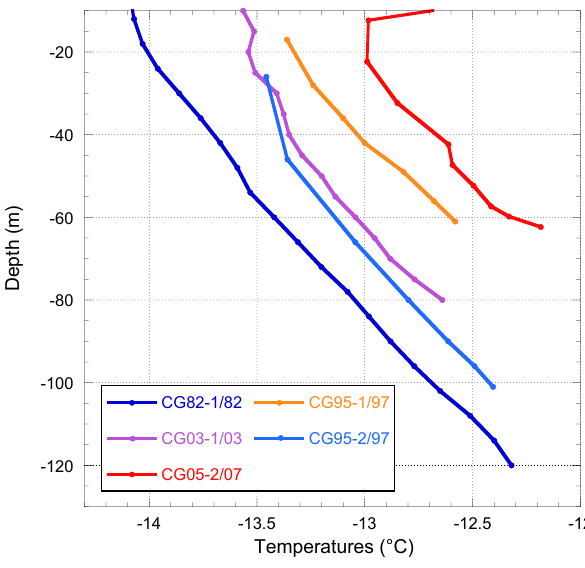
Fig. 8. Temperatures measured in SJ98-A/99 (Suter 2002) at Seser- joch, compared with the new measurements at SJ08-6/08.